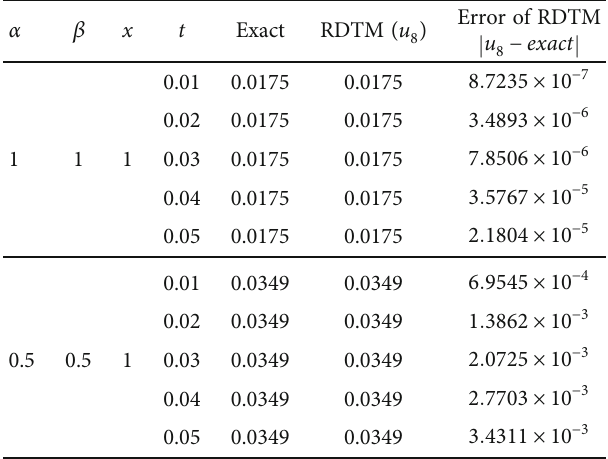
Table 4: Eighth-order approximate solution by RDTM of Example 19 for di ff erent values of α , β , and t and comparison with the exact